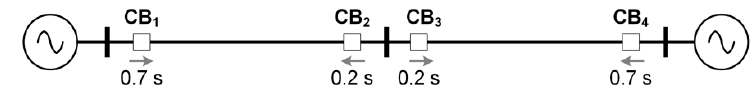
Figure 7. Grading scheme of the tested system.